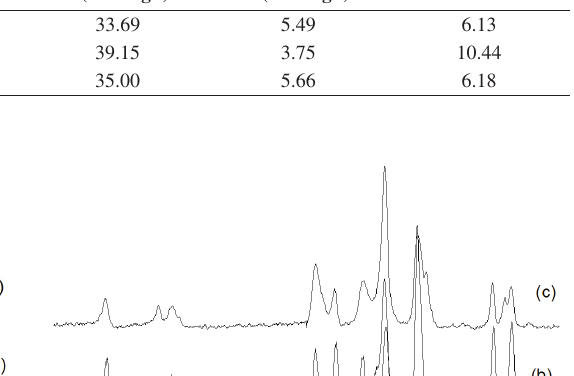
Table 1. Elemental analysis of Carbon (C), Nitrogen (N), molar amounts of these elements and the respective ratios (C/N) between these elements to chitosan and its derivative. Sample